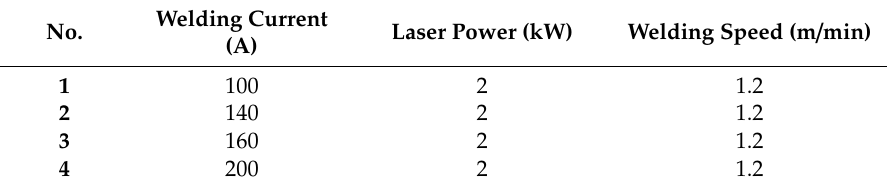
Figure 2. X-ray NDT photos of a typical aluminum alloy weld ( a ) and extraction of the weld pore area ( b ) ( I = 160 A).